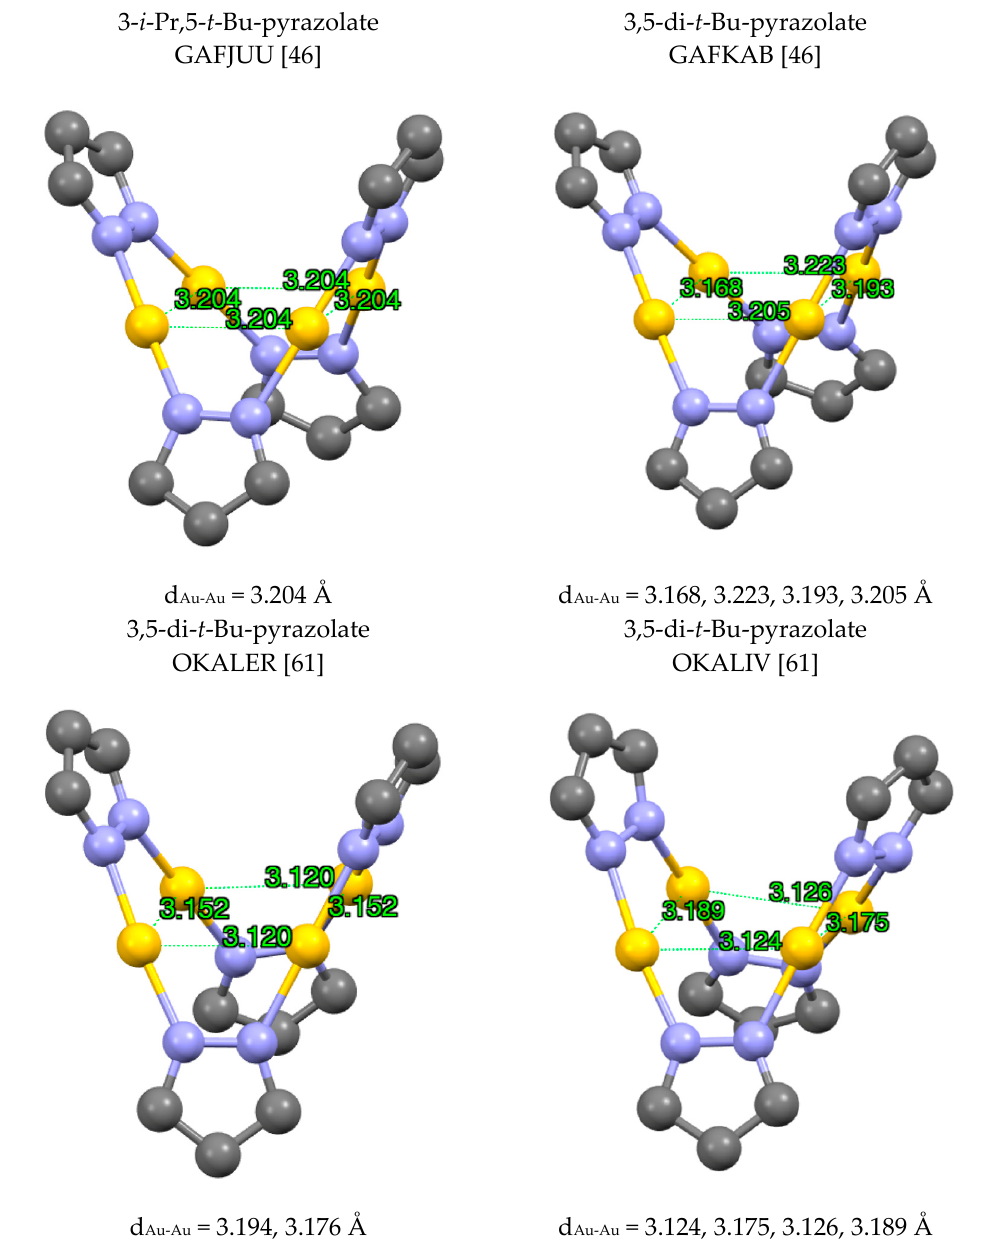
Figure 11. Different modes of (pzAu) 4 complexes. Only the gold atoms and the pyrazolate rings are